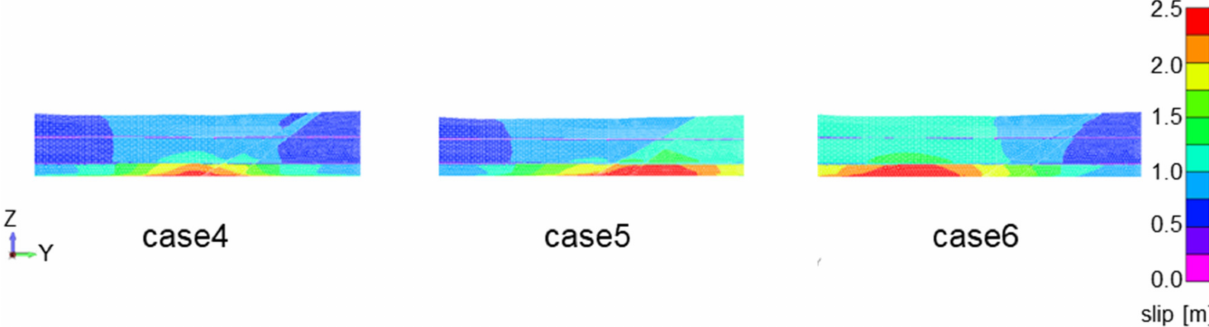
Figure 19. Slip distribution on the main fault (case4 to